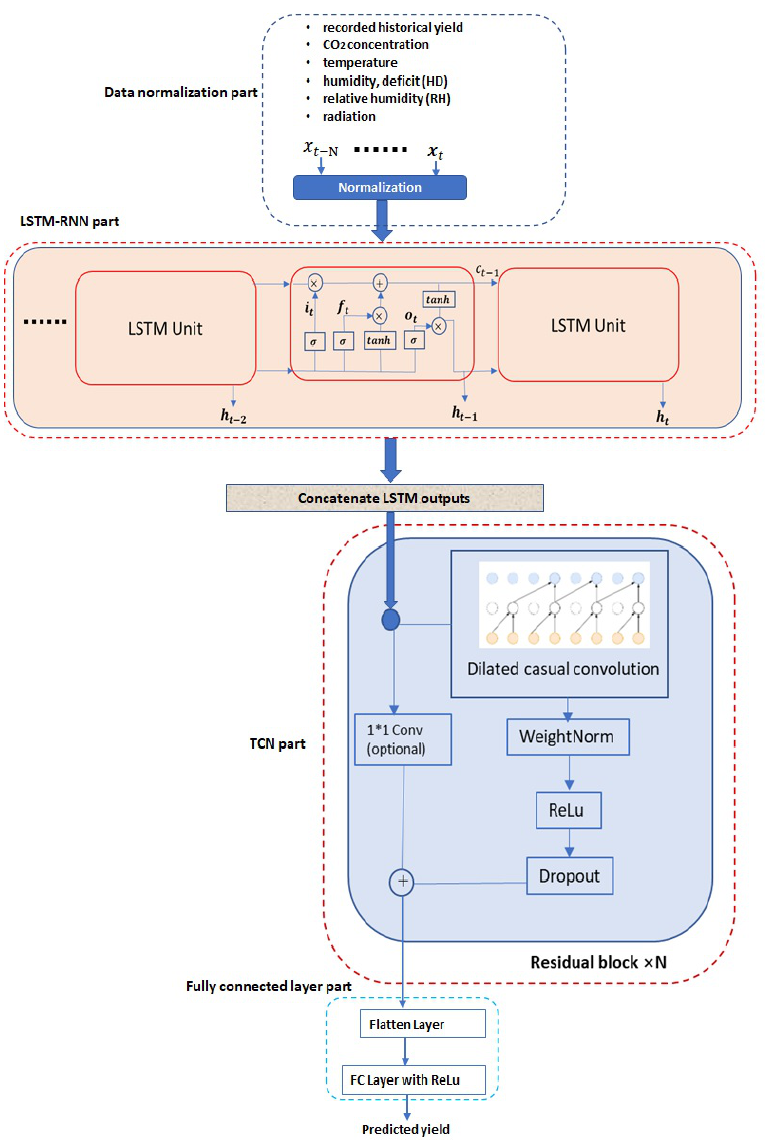
Figure 1. Proposed DNN